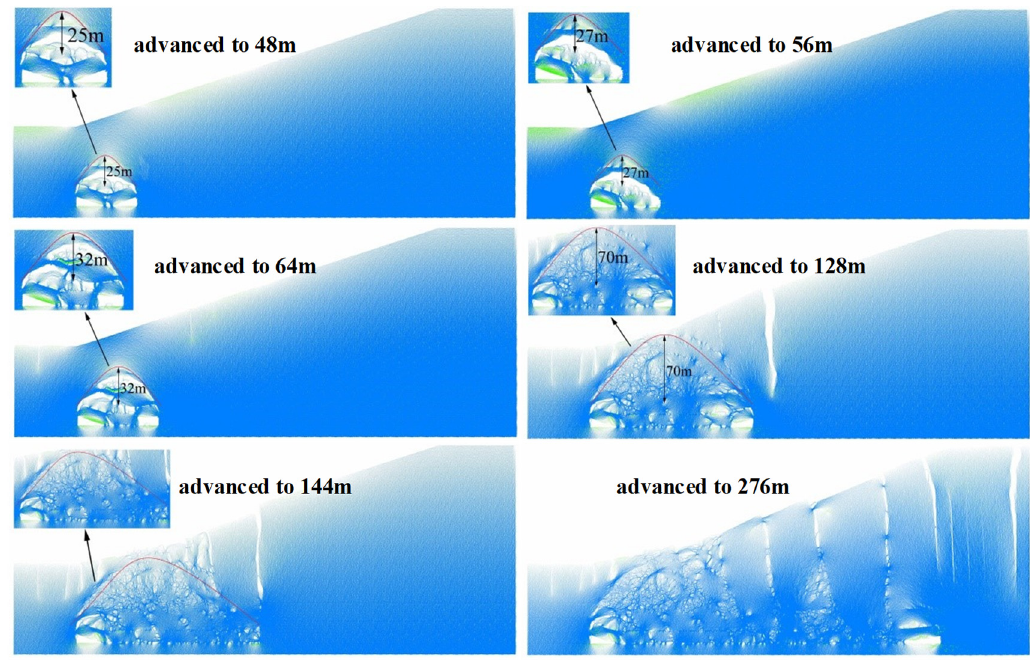
Figure 16. Numerical simulation of evolution of force